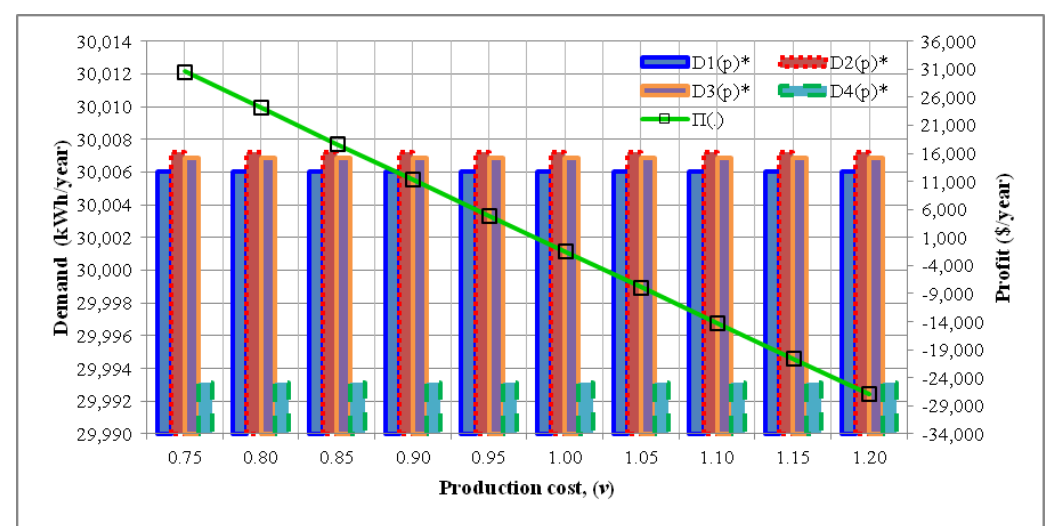
Figure 5. The Effect of Changes in the Production Cost on Profitand Demand.